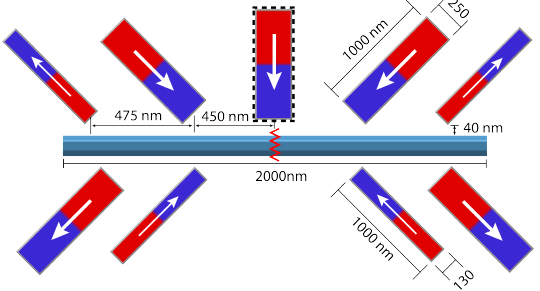
Figure 11: The double Dragonfly setup with the magnet in the middle and a potential gate, dimensions given. Toggling this gate allows the left and right side of the wire to be coupled or uncoupled.